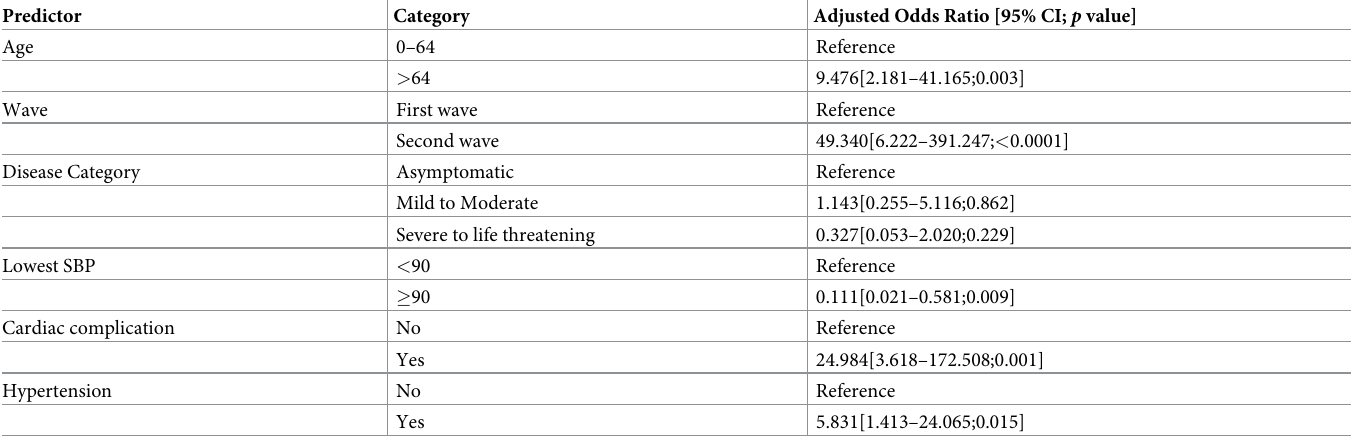
Table 5. Predictors of mortality in multivariate analysis (logistic regression); log likelihood ratio—26.832, pseudo R2 = 0.517.